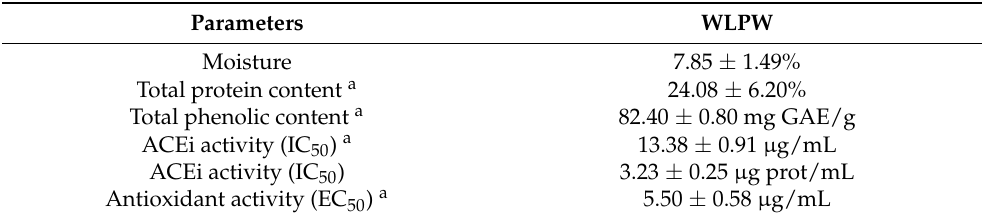
Table 1. Characterization of wine lees powder